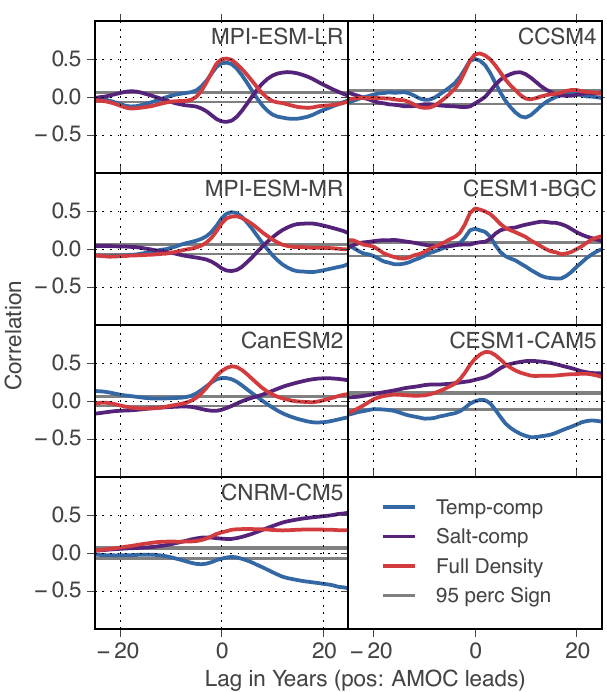
Fig. 9. Cross-correlations between AMOC and NADO density and its temperature- and salinity-related components (positive: AMOC leads). The grey lines mark the two-tailed 95% significance range.